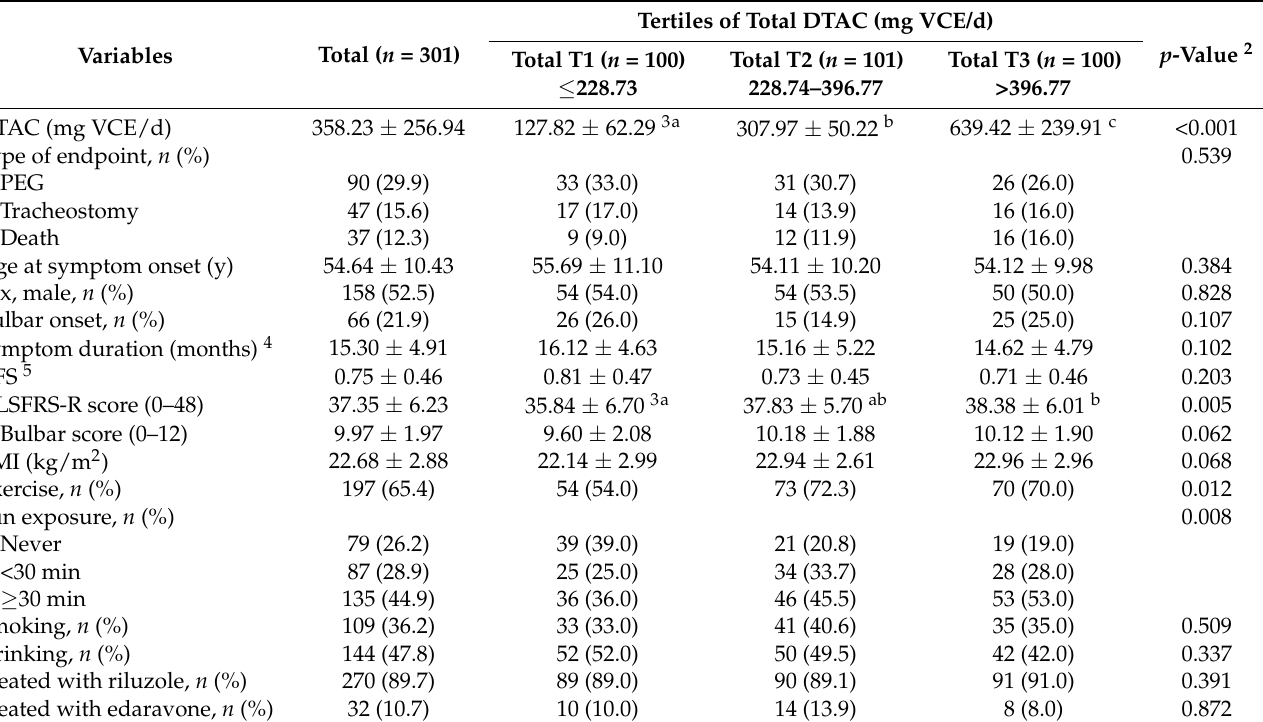
Table 1. Demographics and clinical features of the participants according to tertiles of dietary total antioxidant capacity (DTAC) 1